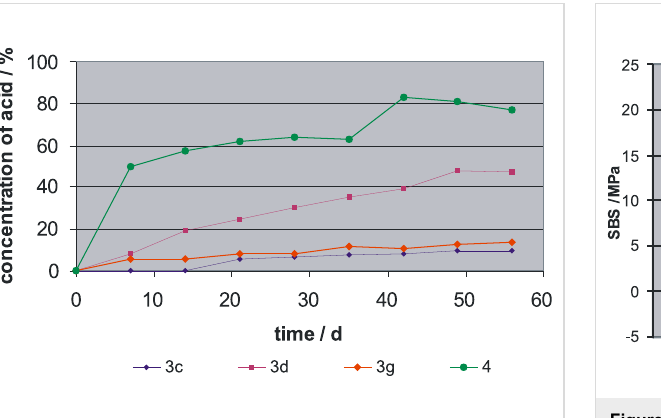
Figure 3: Shear bond strength (SBS) of phosphonic acids 3c , 3e , 3f and 3g in a formulation of an aqueous ethanol solution of N , N ′-diethyl- 1,3-bis(acrylamido)propane, phosphonic acid 3 , and 3(4),8(9)- bis(acrylamidomethyl)tricyclo[5.2.1.0 2,6